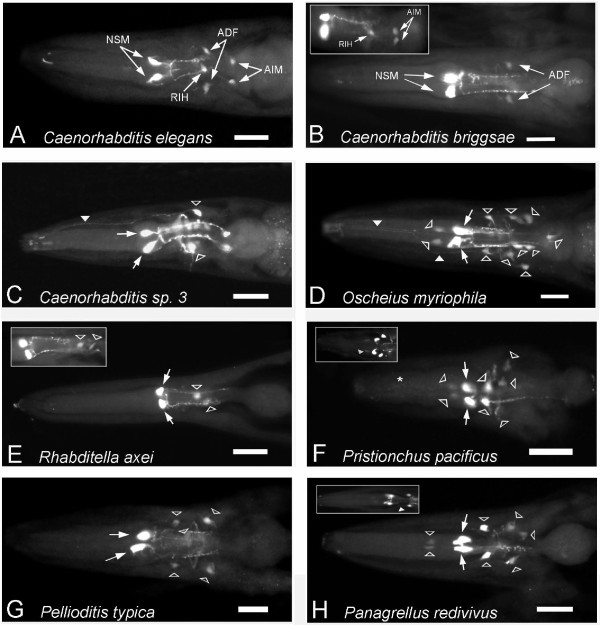
Serotonergic head neurons in free-living Rhabditid nematodes. All panels show serotonin immunoreactivity in whole-mount heads of adult nematodes. Anterior is to the left, ventral view. Calibration bars in each panel are 20 μm. In B-H, arrows indicate NSMs, open arrowheads indicate other serotonin immunoreactive somata, and closed arrowheads indicate serotonin immunoreactive processes. (A) C. elegans (N2) with labeled neurons. (B) C. briggsae (AF16). (C) Caenorhabditis sp. 3 (PS1010). The two large bright spots in the posterior bulb of the pharynx are large NSM-associated varicosities, and not somas. [Double-labeling with DAPI staining shows no nuclei are associated with these blobs.] The filled arrowhead indicates a neurite extending to the amphid associated with a putative ADF homolog. (D) Oscheius myriophila (DF5020). (E) Rhabditella axei (DF 5006). Inset: two serotonin-immunoreactive neurons posterior to the NSMs in a different R. axei animal. (F) Pristionchus pacificus (PS312). The asterisk represents the position of serotonin immunoreactive processes occasionally visible extending from a pair of neurons immediately anterior to the NSMs. Inset: a serotonin immunoreactive process extending from a paired neuron located posterior and lateral to the NSM in a different Pristionchus pacificus animal. (G) Pellioditis typica (DF5025). (H) Panagrellus redivivus (PS1163). Inset: a serotonin immunoreactive process extending from a paired neuron located posterior and lateral to the NSM in a different Panagrellus redivivus worm.